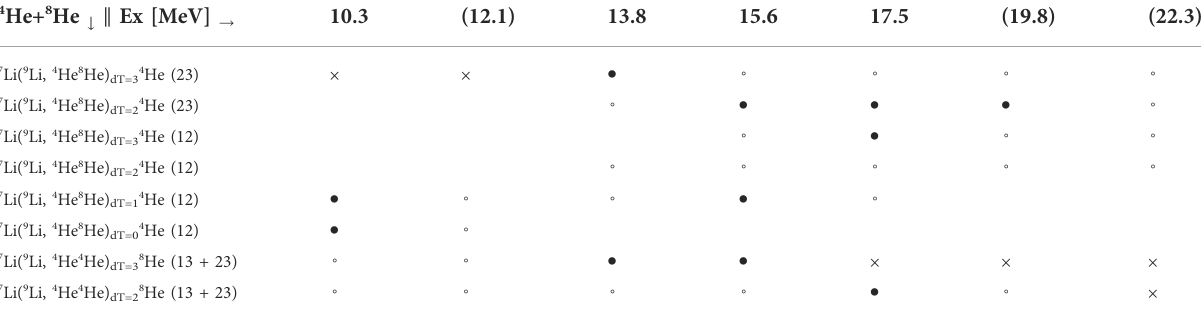
TABLE 3 12 Be excited states observed in the 4 He+ 8 He decay. Observation of a clear peak is labeled with peak obscured by the background or other peaks, or affected by the detection ef fi ciency, with ×. Tentative states are in